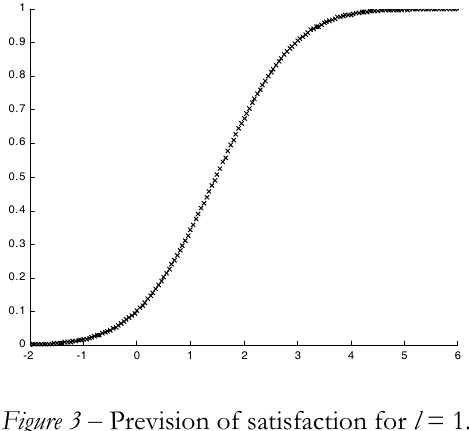
Figure 3 – Prevision of satisfaction for l = 1. Figure 4 – Prevision of satisfaction for l =